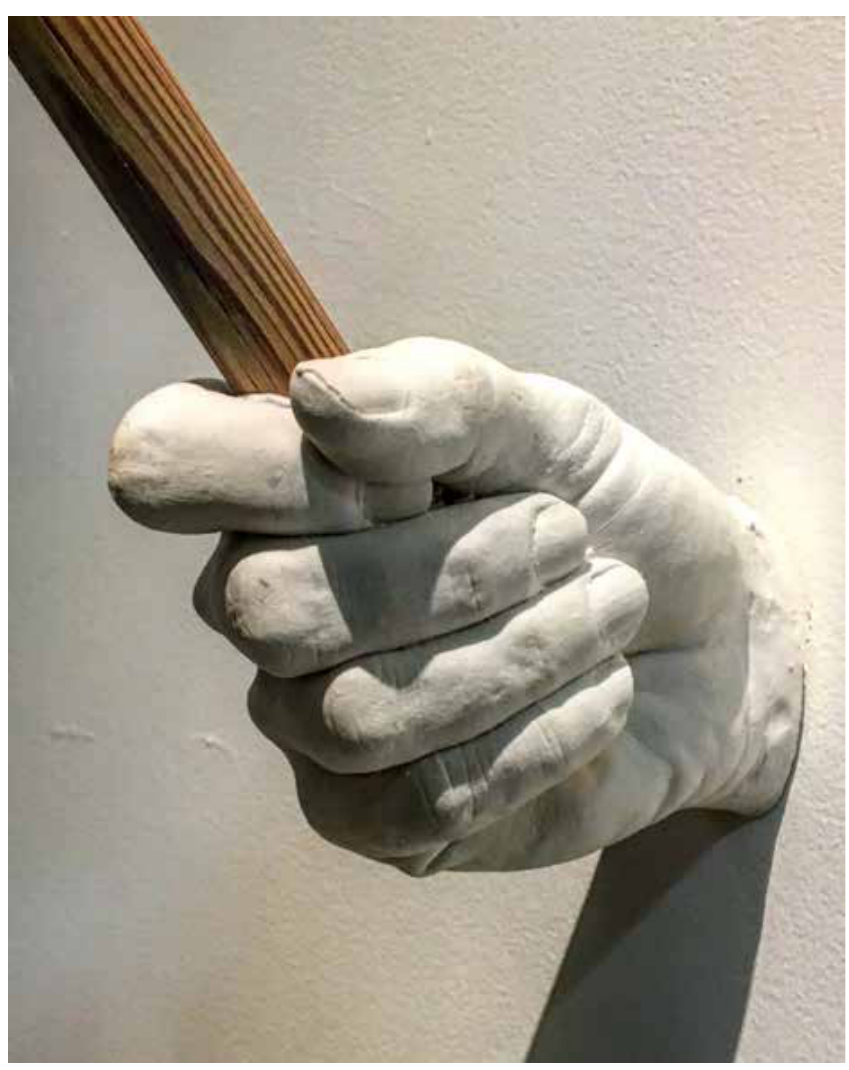
Figure 6: Jenny Roesel Ustick, Run It Up (detail), 2017. Felted wool, wood, and